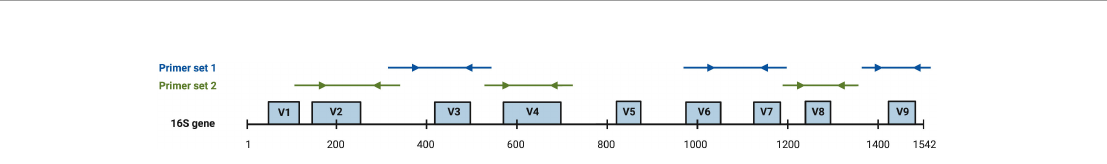
FIGURE 2 ThermoFisher 16s rDNA hypervariable region (hvr) proprietary PCR primer coverage (Barb et al., 2016). Arrows are representative of target binding sites and directionality of ampli fi cation. Primer set 1 achieves ampli fi cation of hvr V3, V6, V7, and V9. Primer set 2 achieves ampli fi cation of hvr V2, V4, and